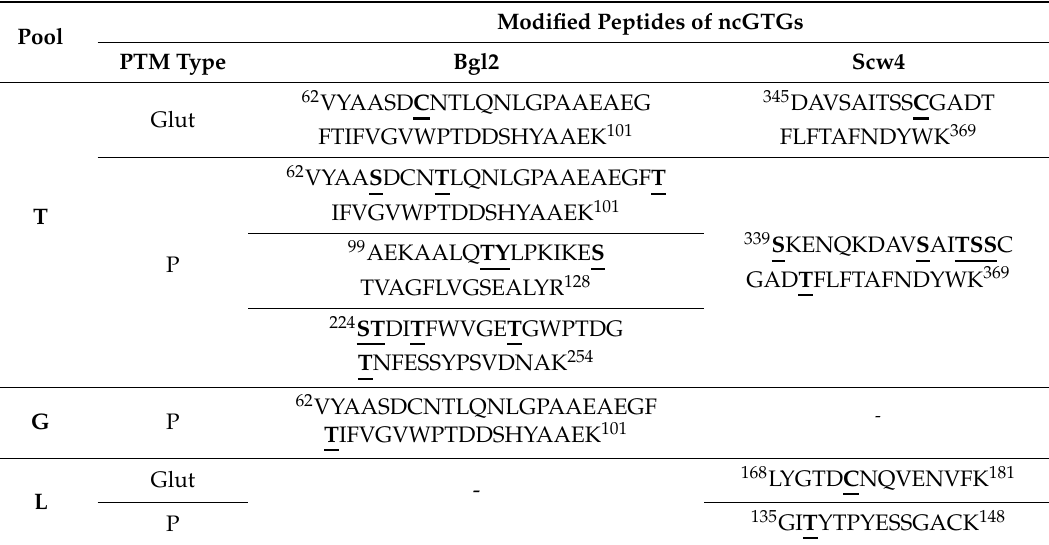
Table 1. Post-translational modifications of Bgl2 and Scw4 in T, G and L pools. Glut—glutathionylation, P—phosphorylation. Modified amino acid residues are underlined and highlighted in bold. Modified Peptides of Pool